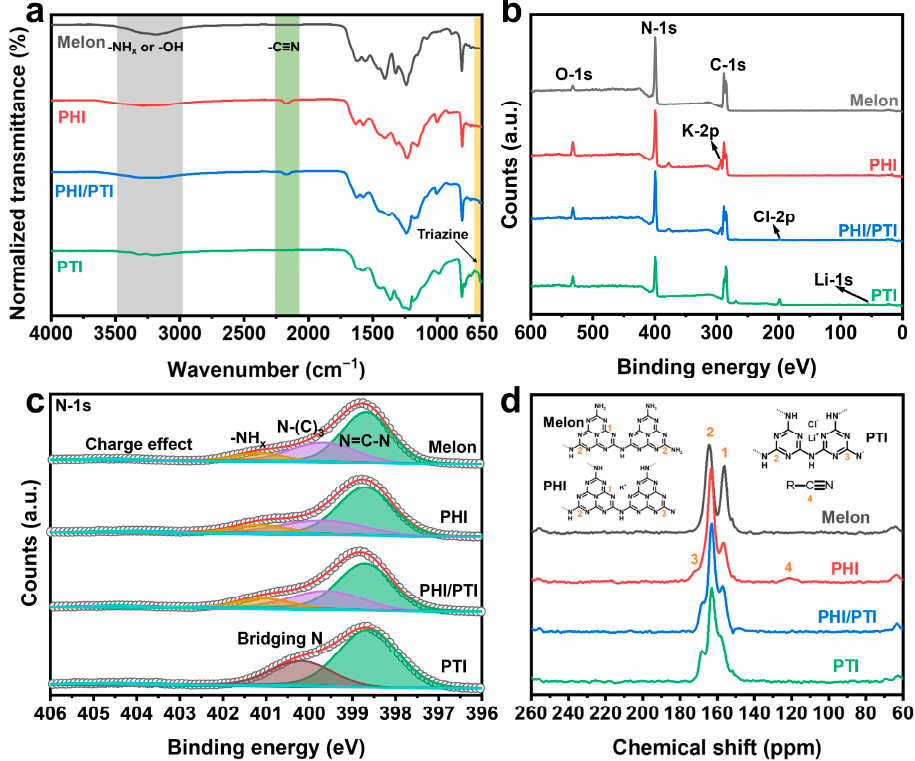
Figure 3. Chemical structures of the g-C 3 N 4 samples. ( a ): FTIR spectra. ( b ): XPS survey profile. ( c ): N-1s High-Resolution XPS profile. ( d ): 13 C CP/MAS NMR